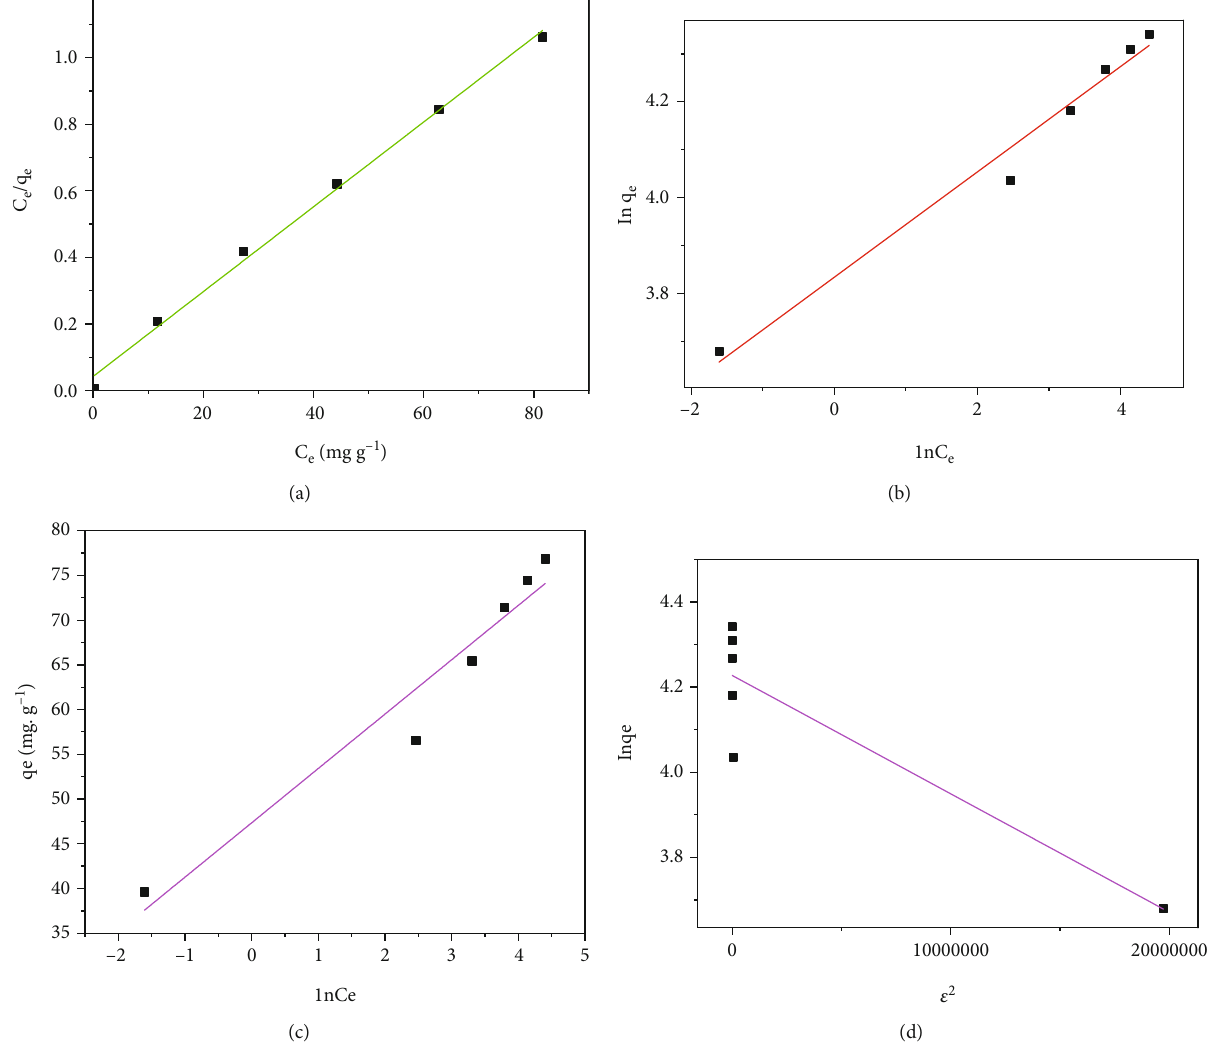
Figure 5: Isotherm models plots for CIP adsorption. (a) Langmuir, (b) Freundlich, (c) Temkin, and (d)